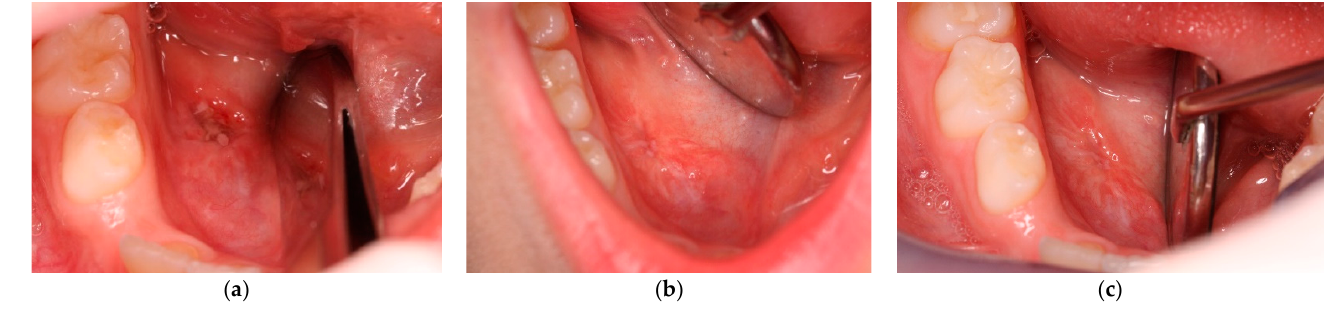
Figure 6. Clinical re-evaluation at ( a ) 48 h; ( b ) 7 days; and ( c ) 12 months of